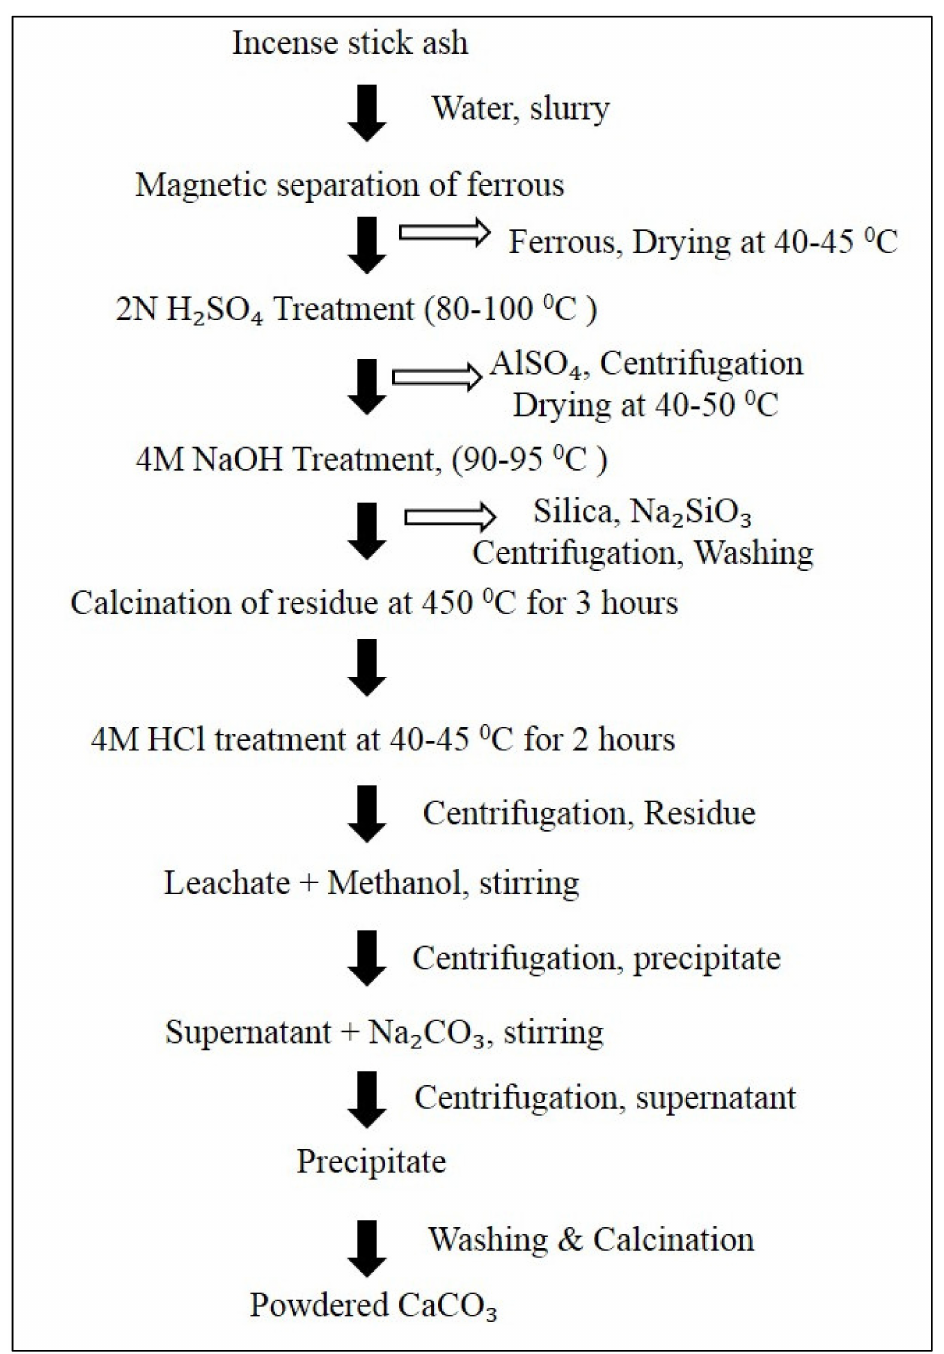
Figure 10. Flow chart for the synthesis of CaCO 3 from incense stick ash, adopted from Yadav et al., open access journal Applied Sciences, 2021